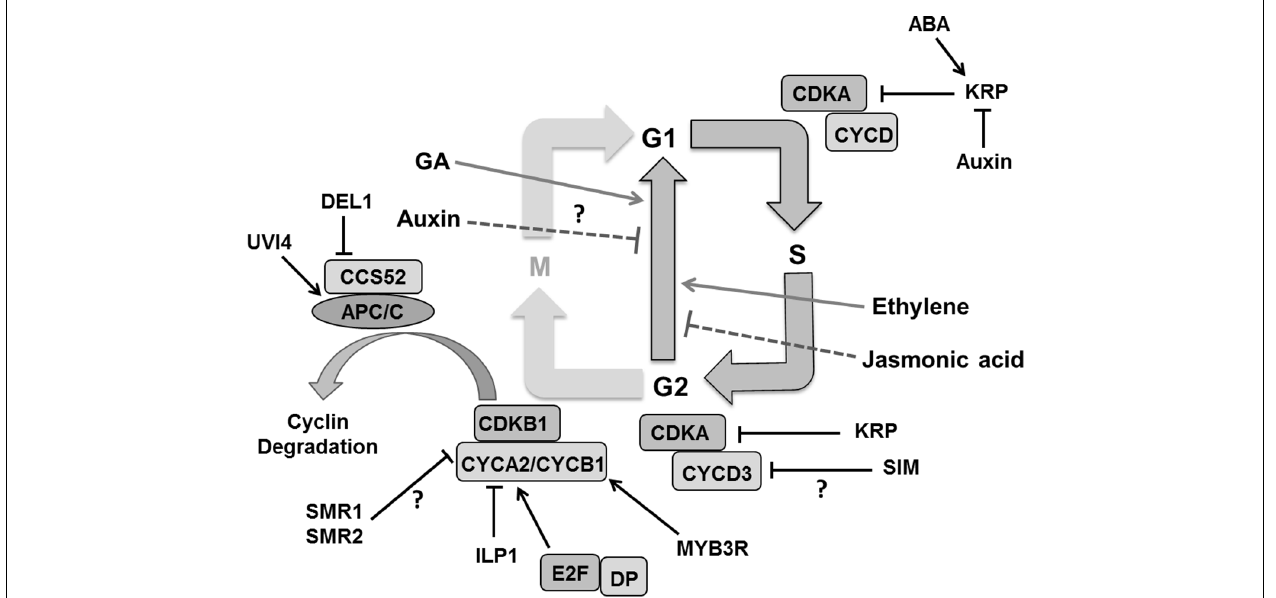
FIGURE 7 | Regulation of endoreduplication. CDKA/B and CYC activity is inhibited by cell cycle inhibitors KRPs/SIM/SMRs that induce endoploidization. Cyclin A is inhibited by the ILP1 proteins whereas down-regulation of MYB3R causes decreased CYCB and ultimately induces endoploidization. Proteolytic degradation of G2–M cyclins by the APC/C complex causes endocycle onset. Other factors like, UVI4 and DEL1